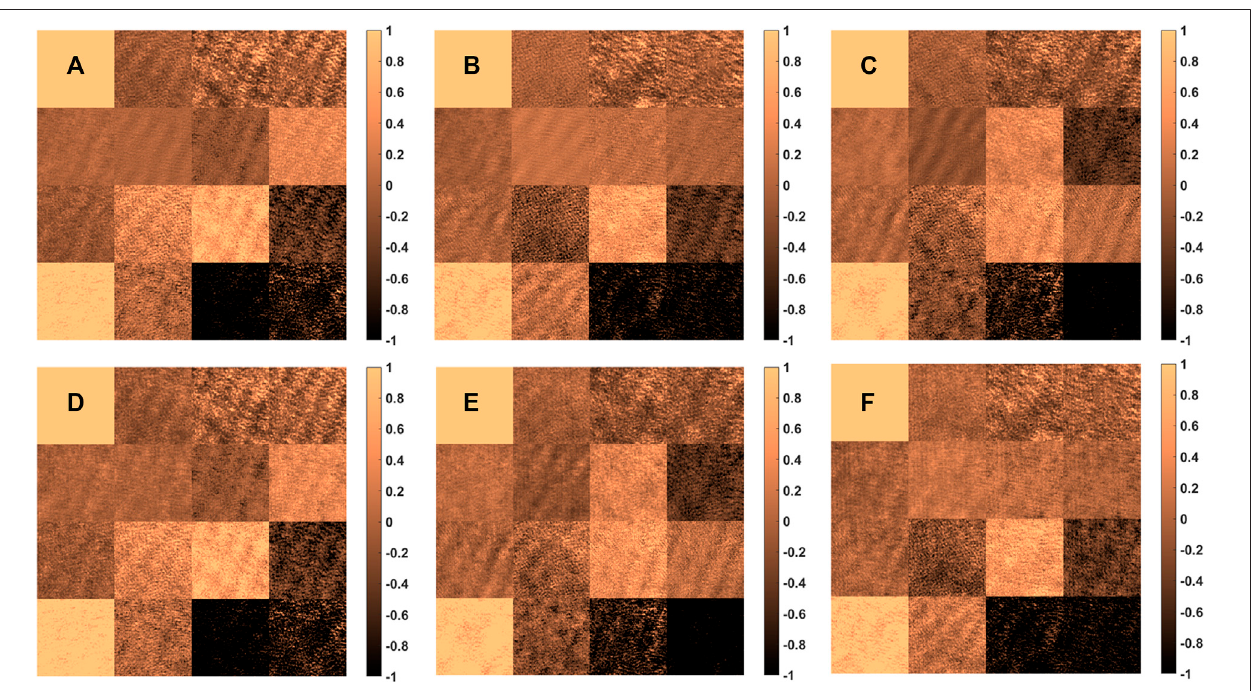
FIGURE 4 | Mueller matrix images at three gray values (0, 128, and 255) of SLM at central part of SLM display (A – C) and the left edge of SLM display (D – F) , respectively. All Mueller matrix elements are normalized with respect to M 11 .